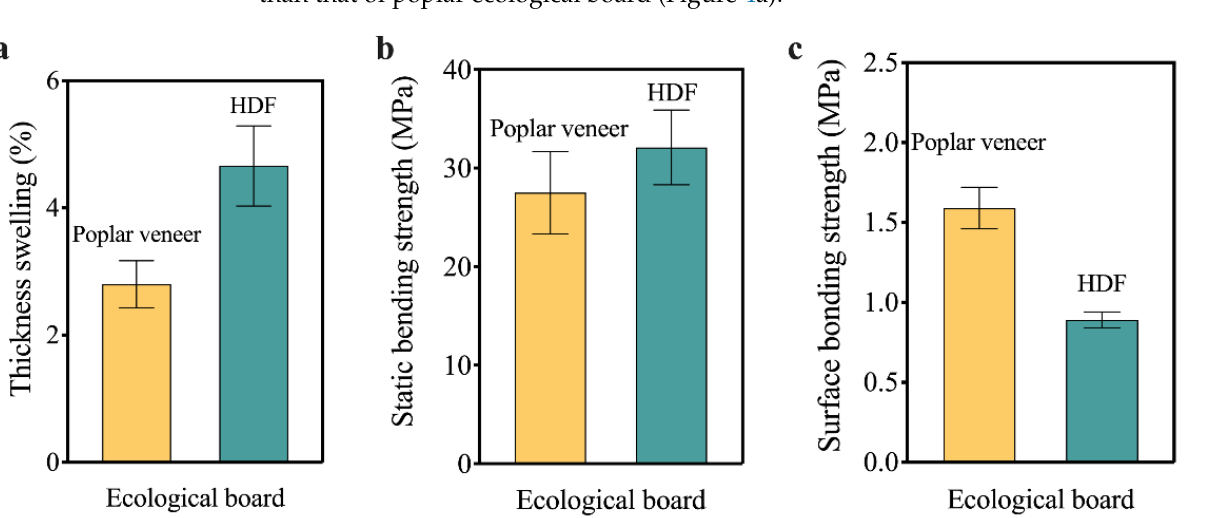
Table 2. Surface wear resistance of ecological board prepared with different equilibrium layers. Equilibrium Layer Wear Revolutions (R) Wear Values (mg/100 r) Surface Wear Condition HDF 350 61 No bottom exposure Poplar veneer 350 55 No bottom exposure